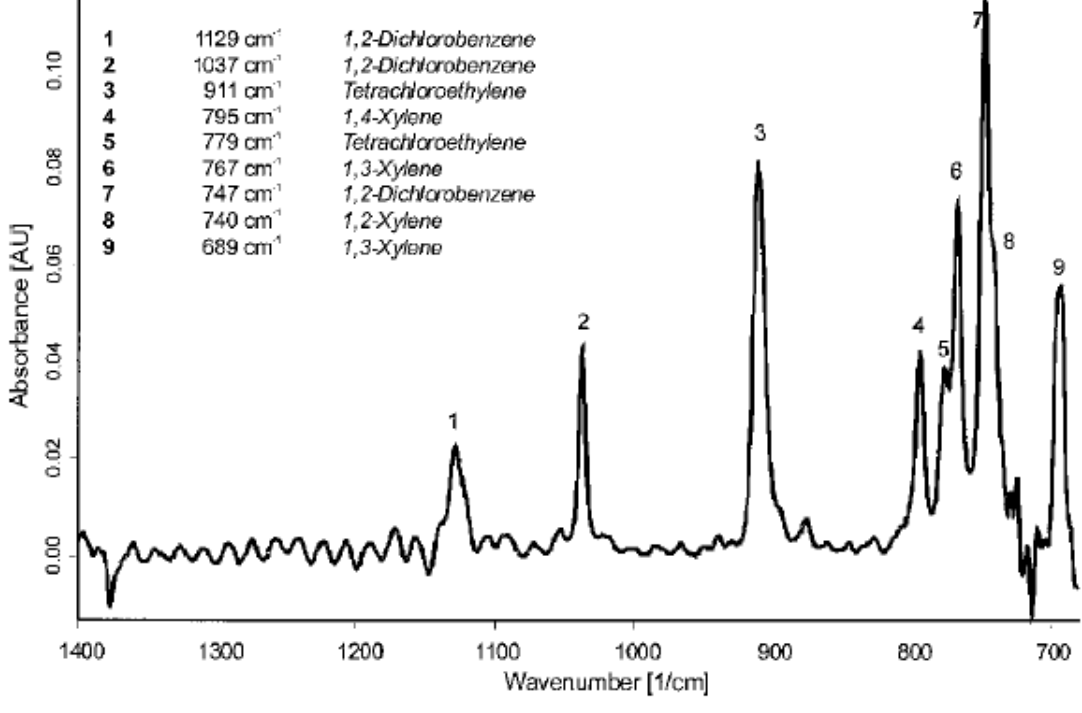
Figure 5. MIR-ATR sensing of various hydrocarbons from different families. Reproduced from [59] with the permission of the Society for Applied